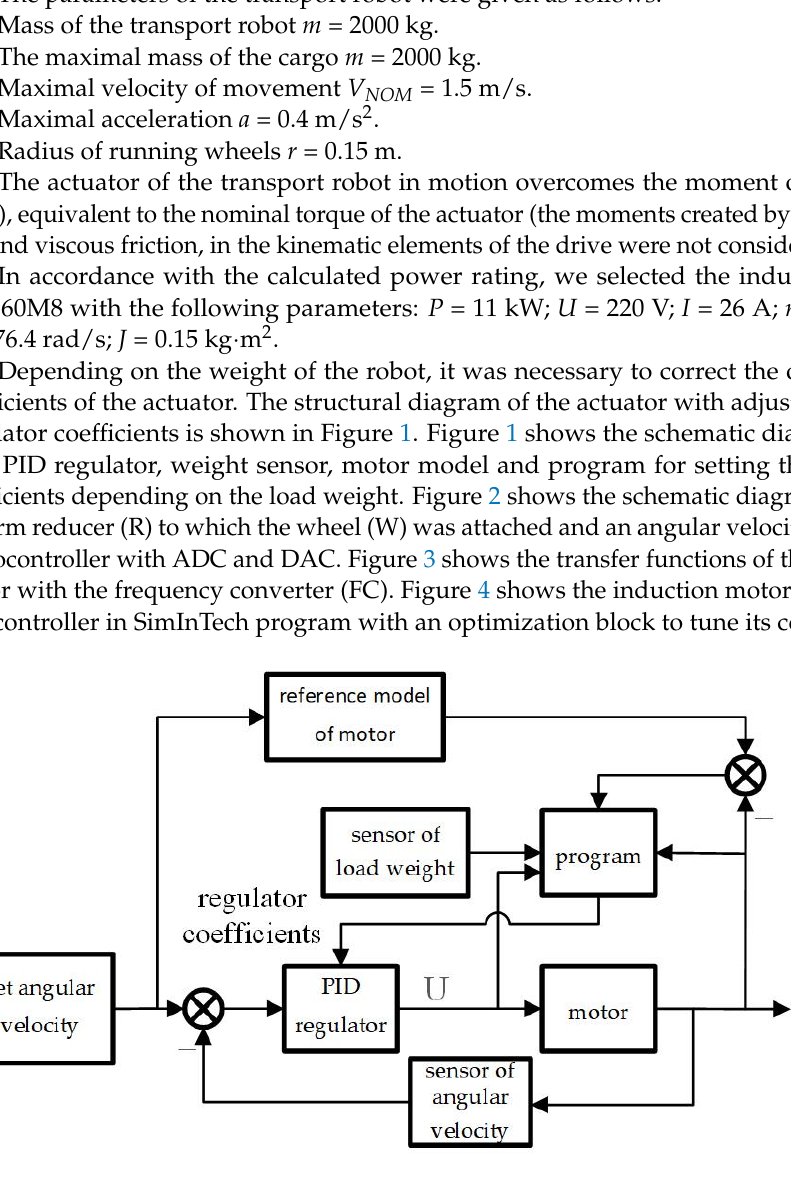
Figure 1. Structural diagram of the